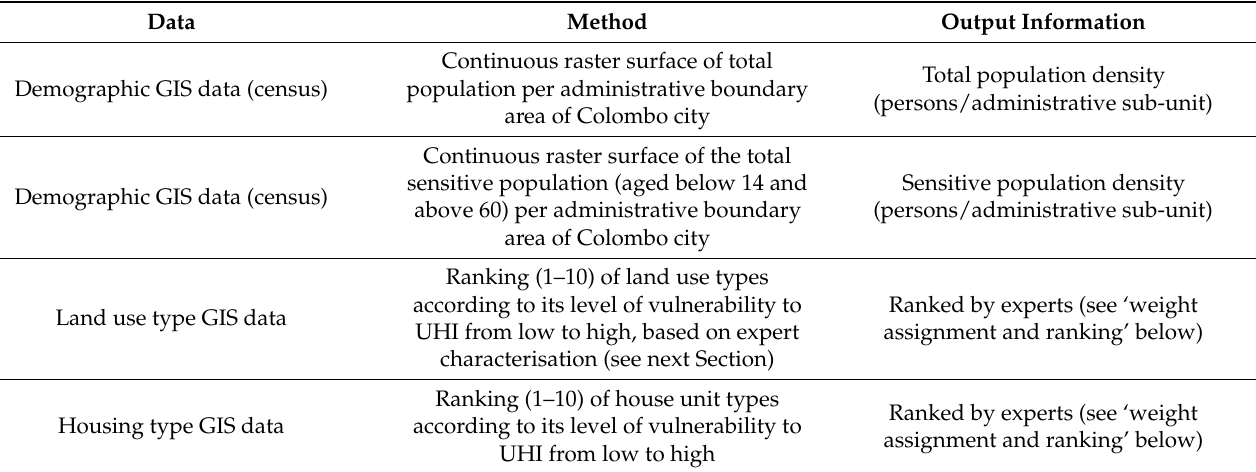
Table 4. Data processing approach—socioeconomic